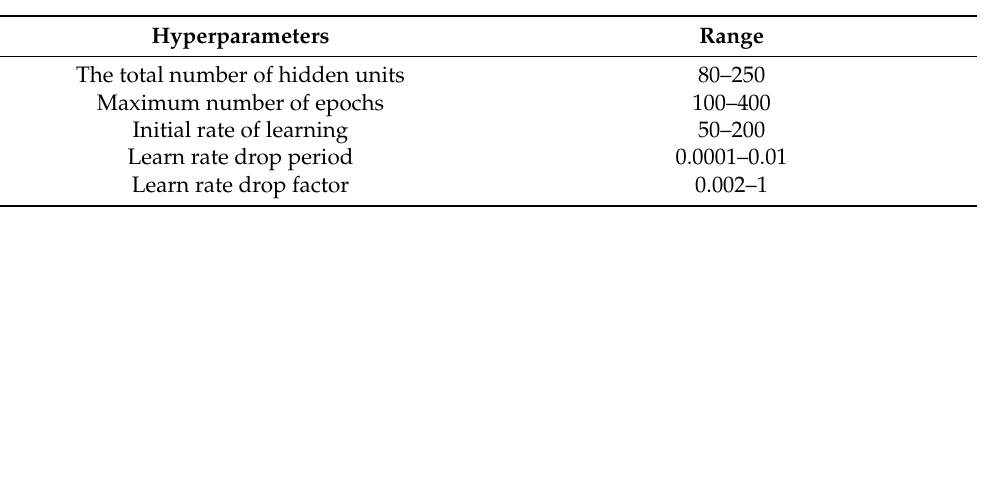
Table 1. Range of the hyperparameters used in proposed